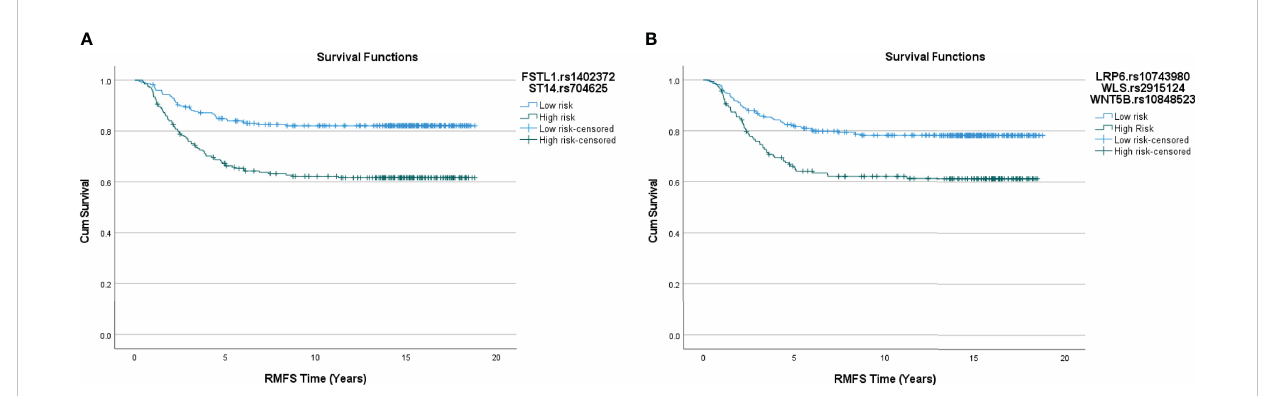
FIGURE 2 (A) Kaplan Meier curve for the Wnt5a interactome, 2-way interaction. Log rank p-value: 2.143x10 -6 . (B) Kaplan Meier curve for the Wnt5a interactome, 3-way interaction. Log rank p-value: 1.296 x10 -4